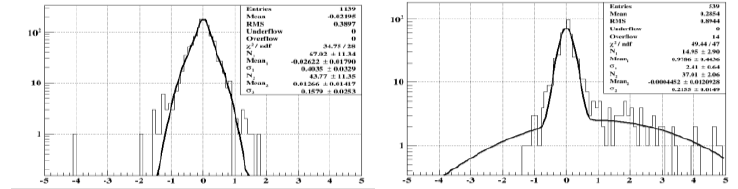
Fig. 3. Left histogram shows the momentum resolution for the single-turn tracks with multi-turn fitting algorithm. Right histogram shows the momentum resolution for the double-turn tracks with multi-turn fitting